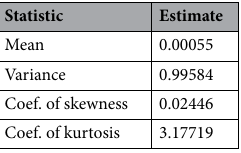
Table 2. Summary of the normalized quantile